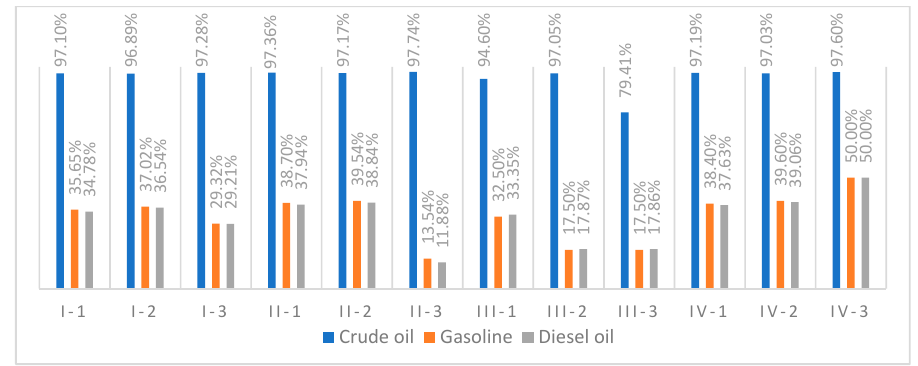
Figure 10. Pipeline transportation proportion.